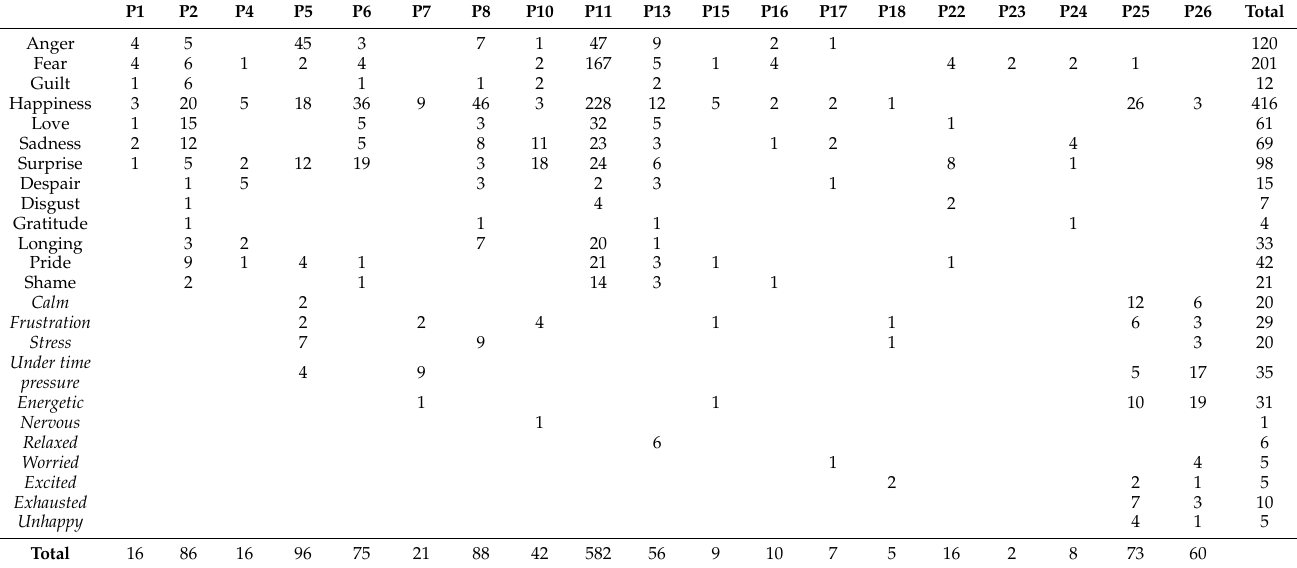
Table 2 summarizes the number of times that each emotion was labelled by every participant. Table 2. Summary of the number of times that each emotion was labelled by every participant (P1–P26). The emotions in italics are the emotions that were not asked to be labelled but were added on initiative of the participants